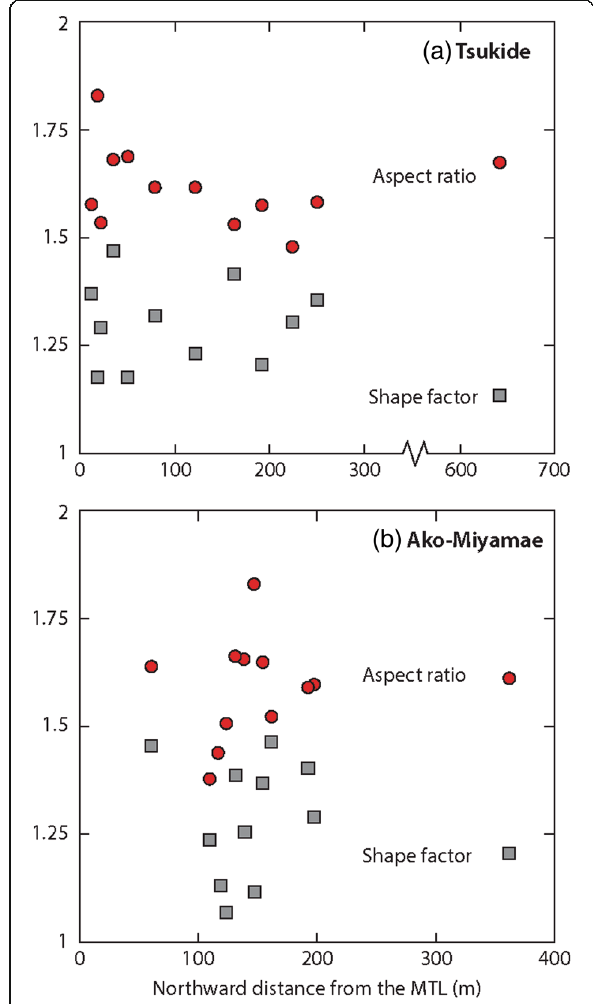
Fig. 6 Variation in aspect ratio and shape factor with distance from the MTL in the Tsukide ( a ) and Ako – Miyamae ( b )